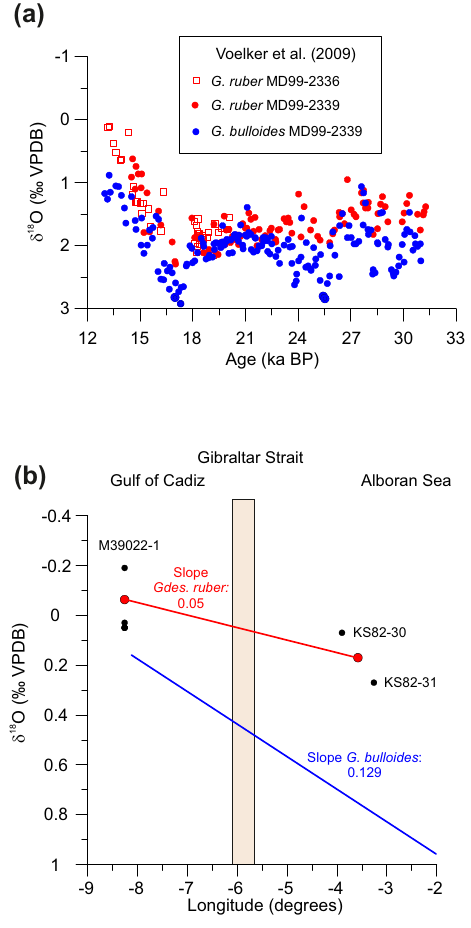
Figure 5. (a) Comparison of Pleistocene δ 18 O values of Globige- rina bulloides and Globigerinoides ruber at sites MD99-2336 and -2339 in the Gulf of Cádiz (Voelker et al., 2009). (b) Recent δ 18 O gradients of Gs. ruber between core top samples from the Gulf of Cádiz (M39022-1; Salgueiro et al., 2008) and the Alboran Sea (sta- tions KS82-30 and KS-82-31; Rohling, 1999). Red circles repre- sent mean values of the respective data sets; the red line denotes the gradient between both basins. For comparison, the gradient ob- tained from the δ 18 O composition of G. bulloides by Rogerson et al. (2010) has been